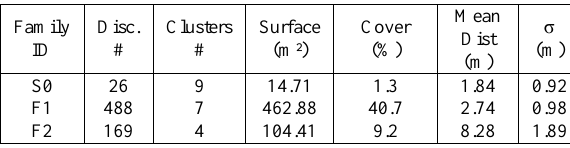
Table 9. DiscontinuityLab results for SuperDisontinuities of the Saulges cliff